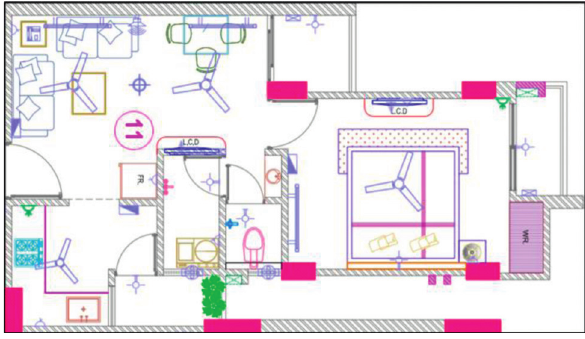
Figure 3: 1BHK flat